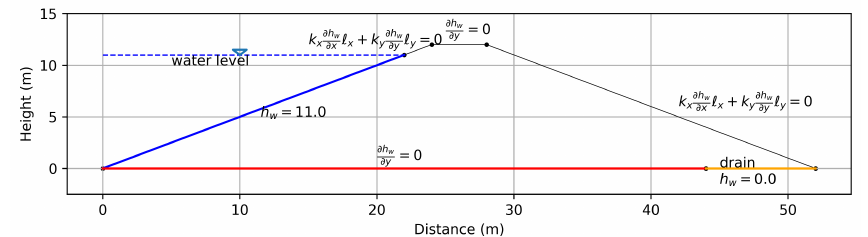
Figure 1. Scheme of the flow dam problem.